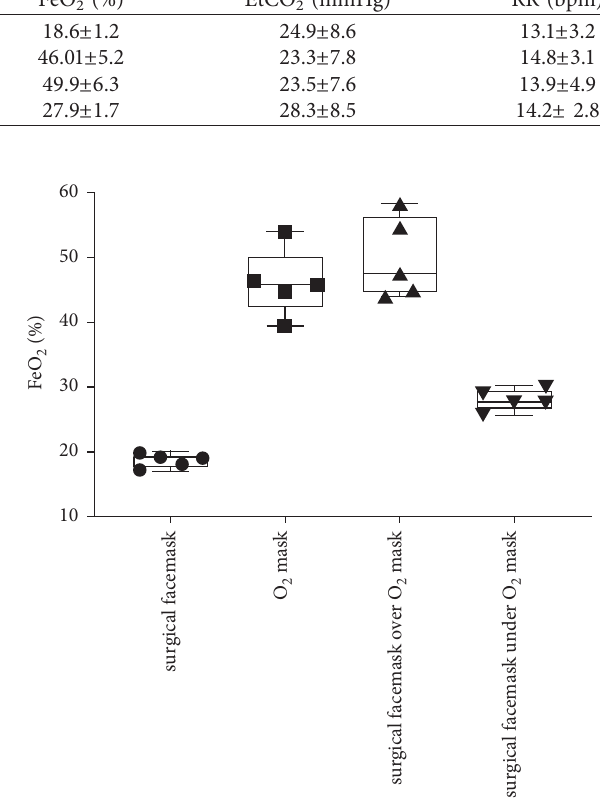
Figure 1: Box and Whisker plots of sampled FiO Figure 2: Box and Whisker plots of sampled FeO 2 at the lips with a 2 at the lips with a surgical facemask only, an O 2 mask only, a surgical facemask over surgical facemask only, an O 2 mask only, a surgical facemask over an O 2 mask, and a surgical facemask under an O 2 mask. The circles, an O 2 mask, and a surgical facemask under an O 2 mask. The circles, squares, and triangles represent average values for each of the five squares, and triangles represent average values for each of the five subjects in the various mask configurations. subjects in the various mask